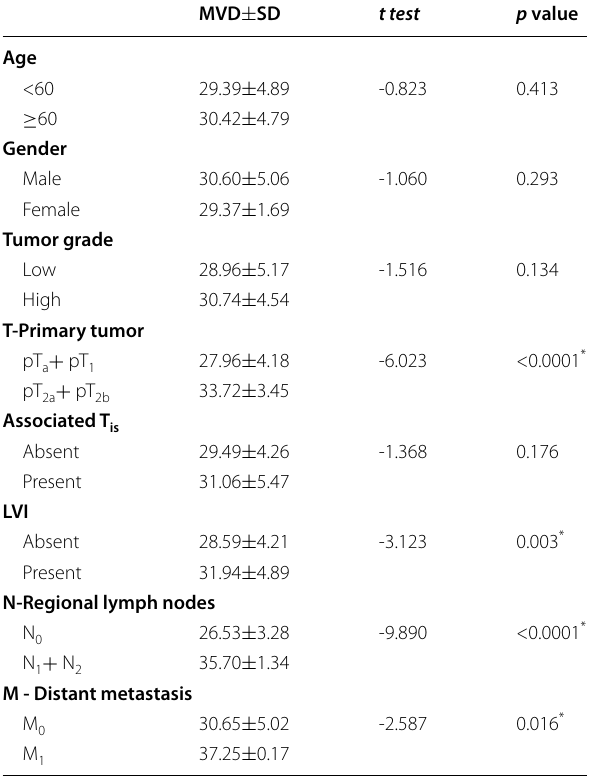
200) in: a low‑grade pT a UC, b low‑grade pT 1 UC, c high‑grade pT a UC, and d high‑grade pT 2